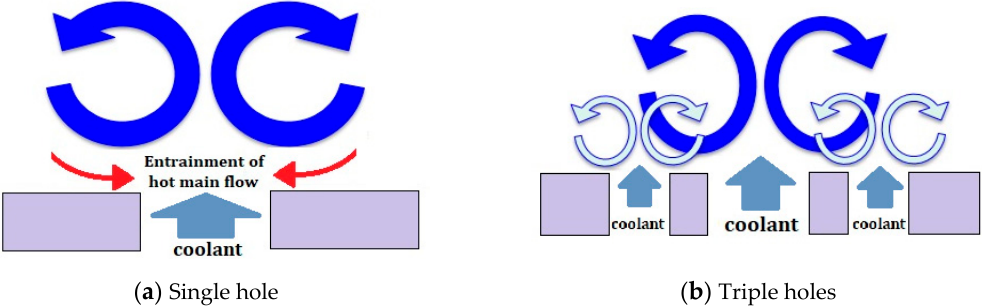
Figure 3. Cross-sectional schematic of a counter rotating vortex pair generated in the single- and triple-hole configurations . Table 1. Boundary conditions of the computational fluid dynamics (CFD) domain.